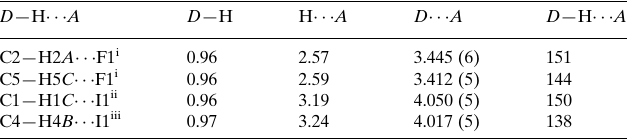
Hydrogen-bond geometry (A˚ , (cid:2)